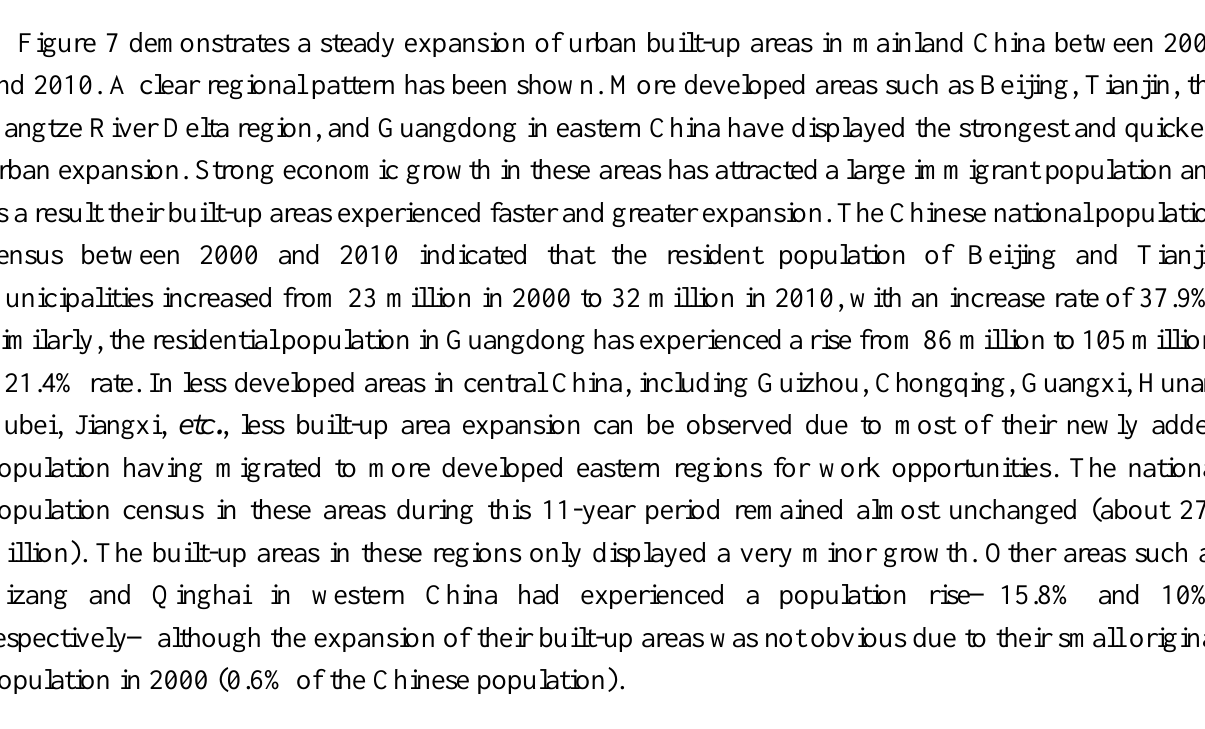
Figure 6. Relationship between the DN threshold of built-up areas and average provincial annual per capital